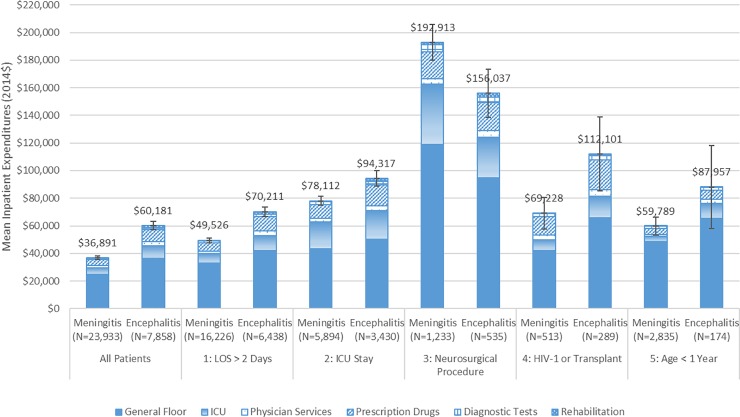
Mean inpatient expenditures by type for hospitalized patient episodes for meningitis or encephalitis by patient subgroup, 2010 to 2014.Notes: LOS: length of stay; IP: inpatient; ICU: intensive care unit The first 90 days and the last 90 days are excluded from the 2010 to 2014 period. Expenditure statistics are based on inpatient expenditures for a patient episode, including re-admissions. Mean expenditures for each type of utilization are calculated using all patient episodes, not just the episodes that had that type of expense. The values reported in the figure are the total mean inpatient expenditures, and the error bars indicate the 95% confidence intervals of these estimated means. Source: Authors’ analysis of 2010 to 2014 Truven Health MarketScan Commercial Claims and Encounters Database.